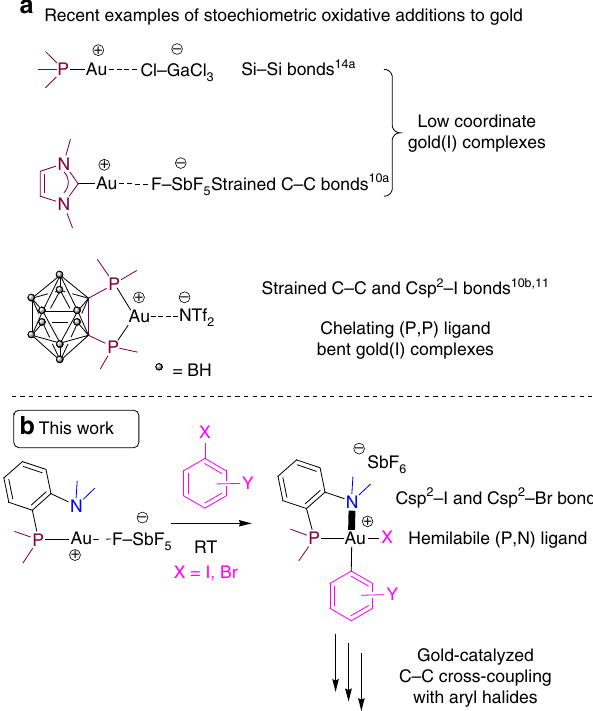
Fig. 1 Intermolecular oxidative additions to Au(I) complexes. a Recent examples of stoichiometric oxidative addition to gold. b This work: mild oxidative addition of aryl halides to gold using a hemilabile (P,N) ligand and gold-catalyzed arylation with aryl